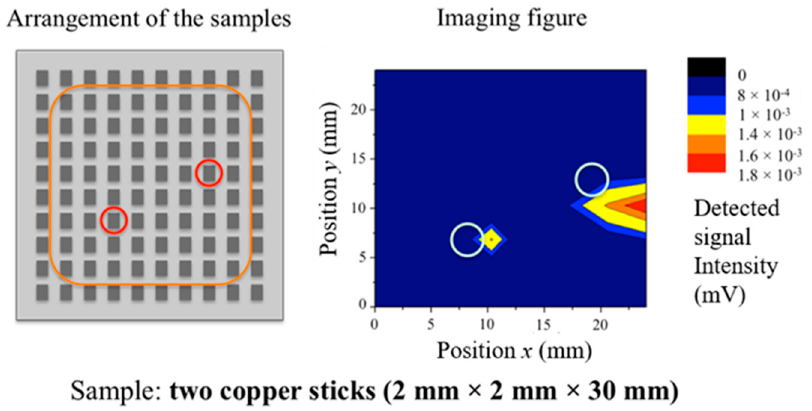
Figure 14. Two-dimensional imaging of conductive samples (two copper sticks).